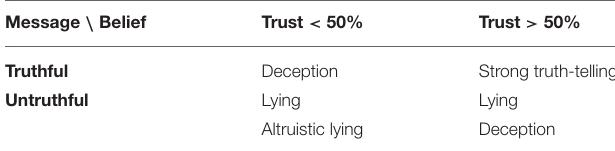
TABLE 2 | Behavioral taxonomy by messages and beliefs. Message \ Belief Trust < 50% Trust > 50% Truthful Deception Strong truth-telling